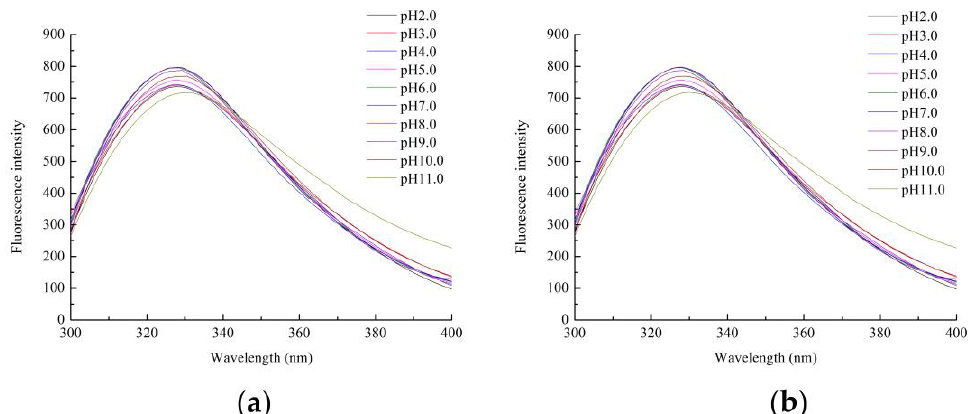
Figure 7. The emission fluorescence spectra of lectin from the Zihua snap bean at various pH conditions at the excitation wavelengths of ( a ) 280 nm and ( b ) 295